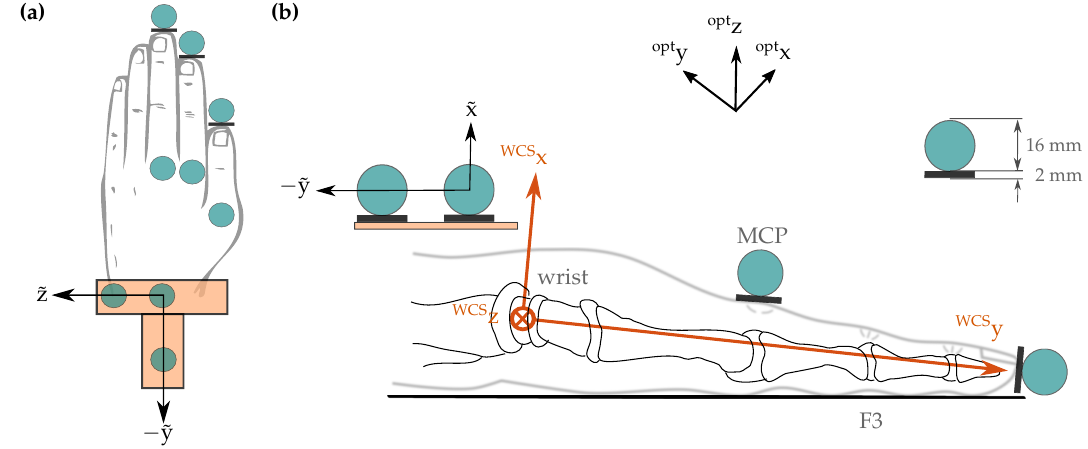
Figure 8. Position of the optical markers visualized as cyan circles, and definition of coordinate systems illustrated in ( a ) top view of wrist and hand, and ( b ) side view of a cut through the middle finger F3 (opt: optical system, WCS: wrist coordinate system, tilde: marker coordinate